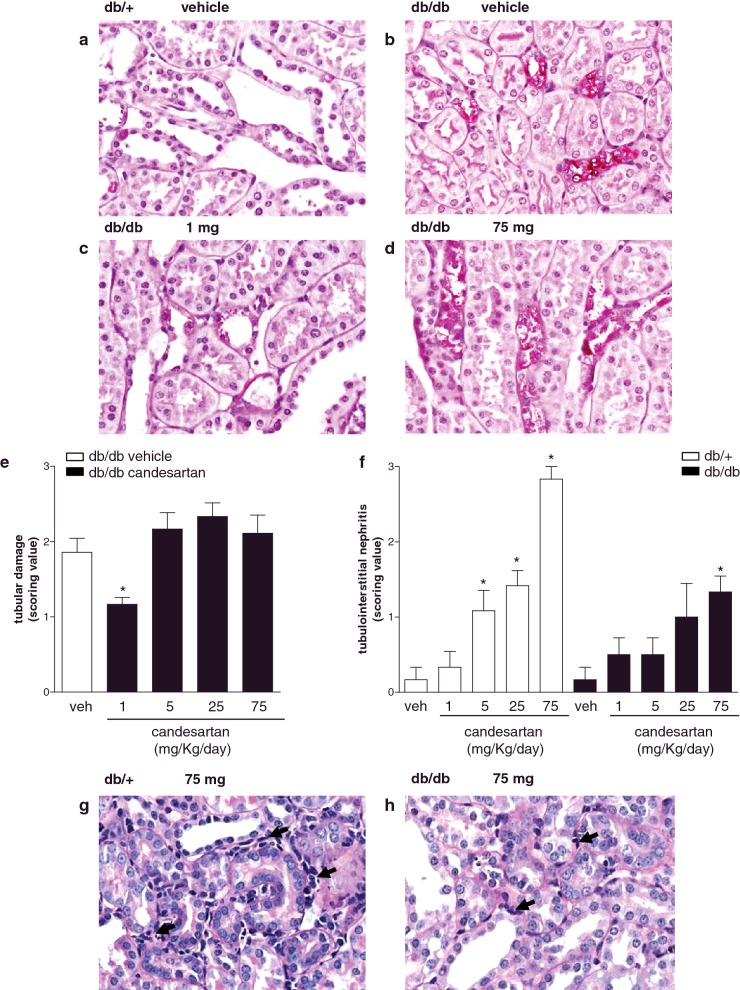
Candesartan (1 mg/kg/d) improves tubular damage in db/db miceMice were daily treated with subcutaneous injections of vehicle or candesartan (1, 5, 25 or 75 mg/kg/d) for 4 weeks. Representative photographs of PAS-stained tubules and interstitium (a–d, g and h). Bar graphs: scores for tubular damage in db/db mice (e) and tubulointerstitial nephritis in db/+ and db/db mice (f). Arrows, indicate cell infiltrates. *P<0.05 compared with vehicle-treated counterpart.